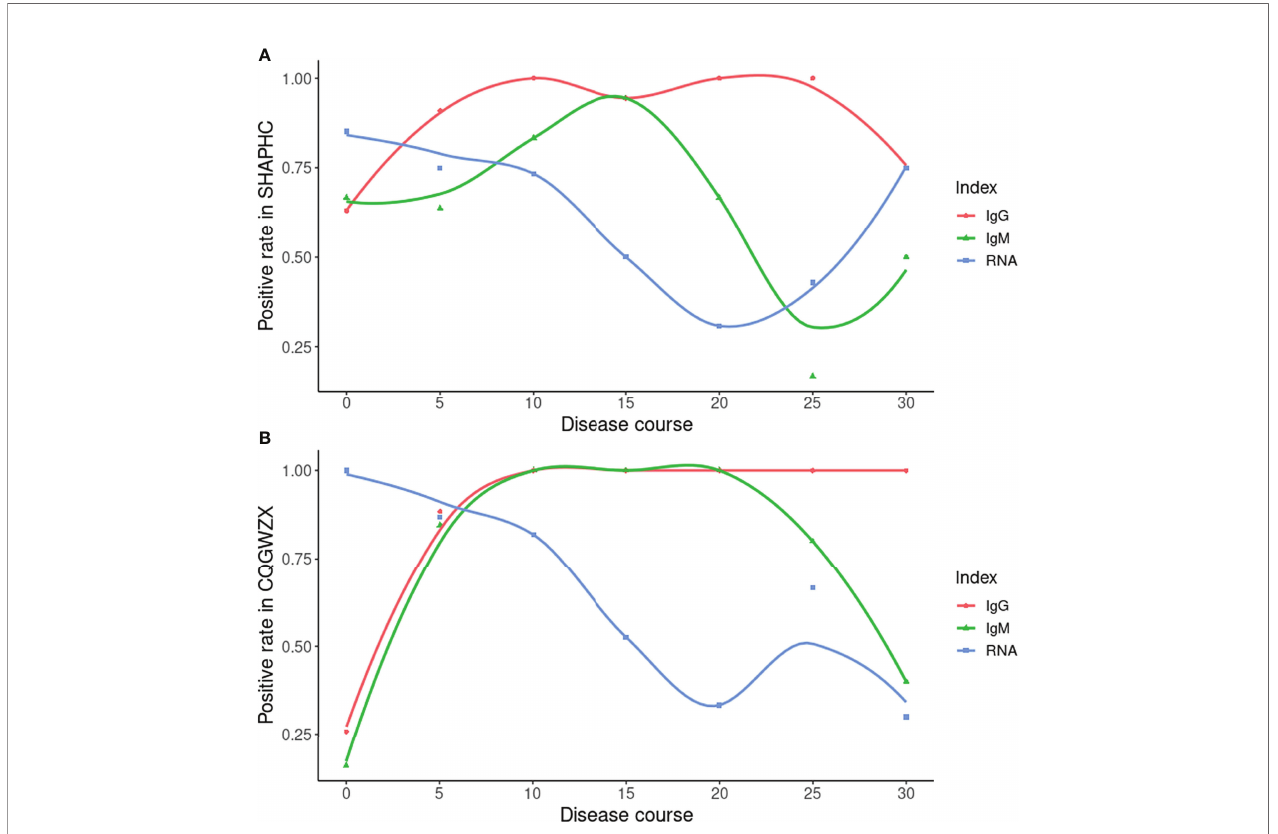
FIGURE 4 | Time-series data from SHAPHC and CQGWZX. (A) Time-series data of 30 COVID-19 patients from SHAPHC; (B) Time-series data of 40 COVID-19 patients from CQGWZX. X axis: starting time point of 5 days period (0 means 0-4 days, 5 means 5-9 days and so forth, except for 30 which means all 30+ days result). Curves were drawn by local polynomial regression fi